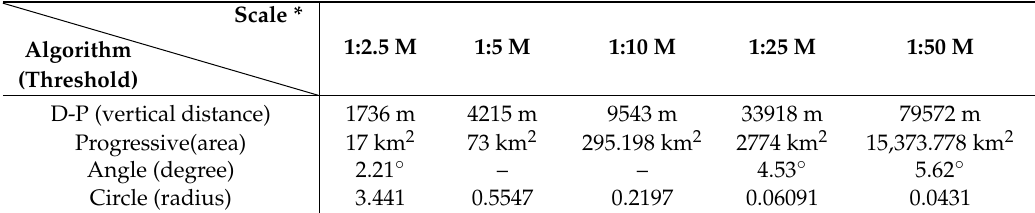
Table 2. The simplification threshold of the four simplification algorithms.